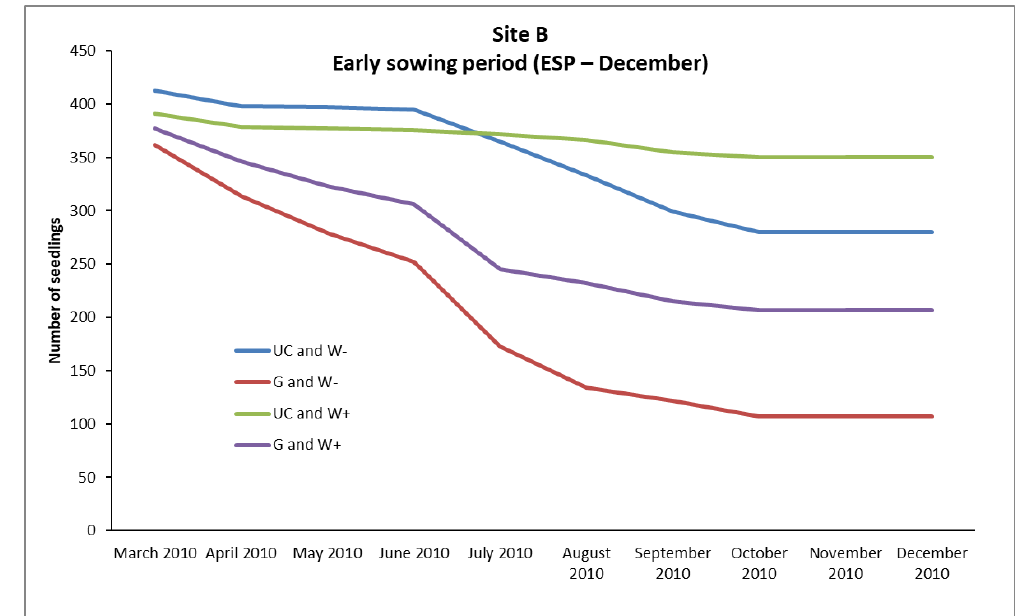
Figure 6. Monthly seedling survival (number of living seedlings) of the December sowing (ESP) in the plots of each combination of the two factor levels in site B for the period March 2010–December 2010 (the March 2010 record shows the number of germinated seeds).